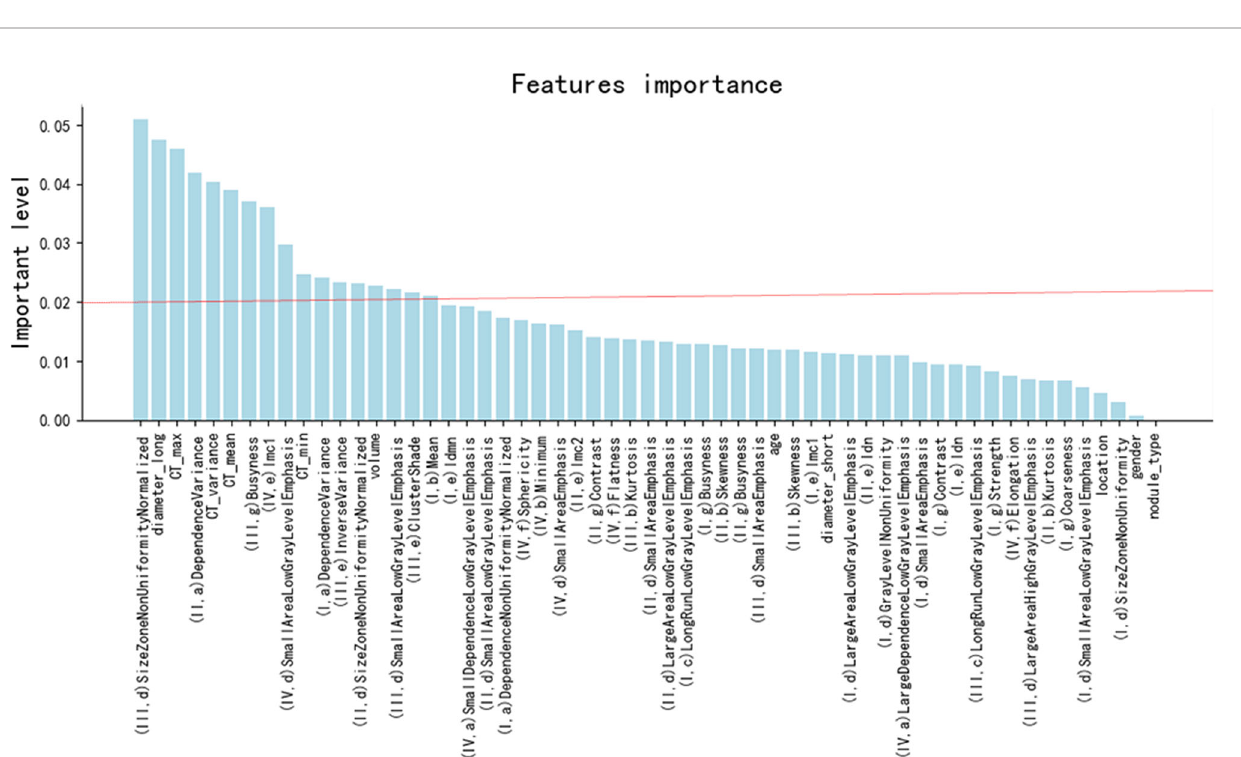
Frontiers in Oncology |